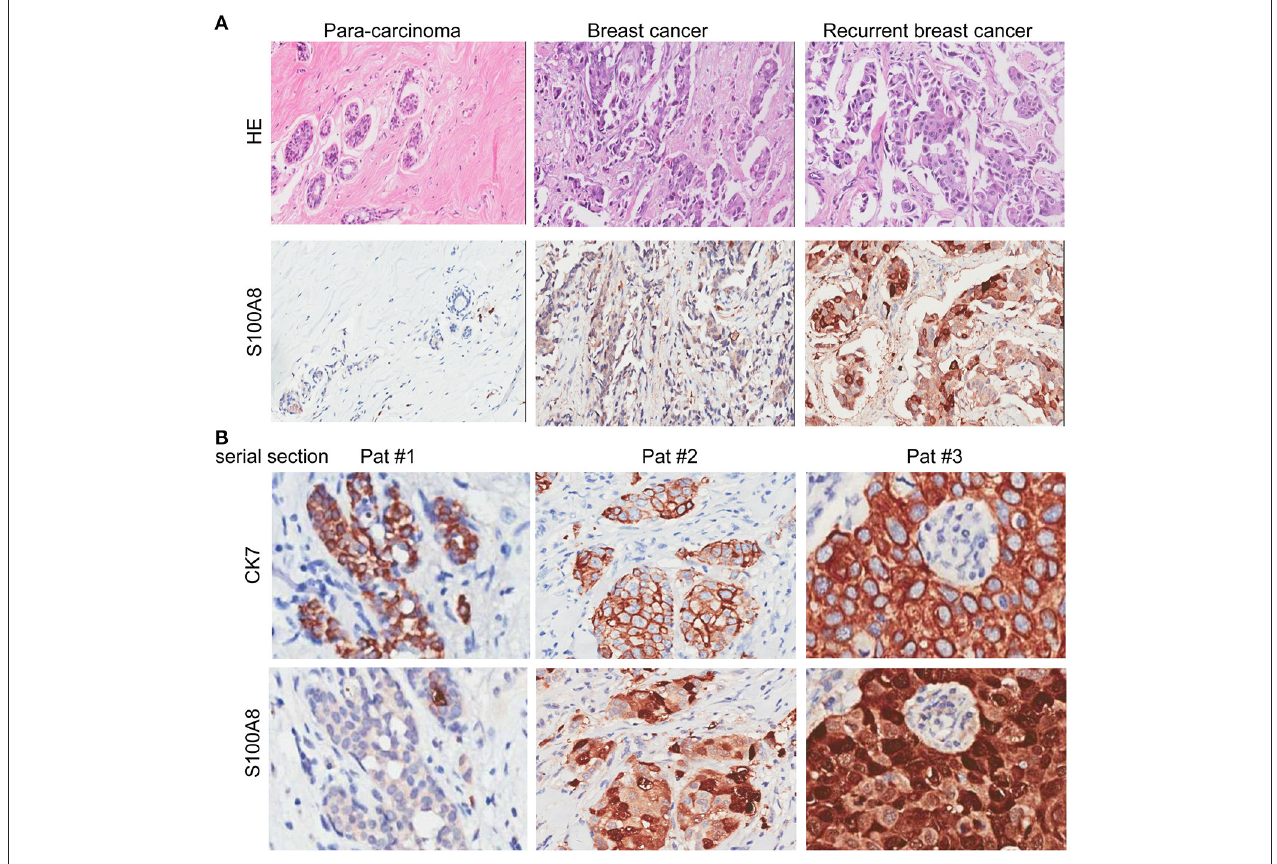
FIGURE 1 | HE and IHC staining of para-carcinoma, invasive breast cancer, and recurrent breast cancer tissue samples. (A) HE staining (top) and immunohistochemical staining (bottom) of the three types of tissue: para-carcinoma (left), invasive breast cancer (middle), and recurrent breast cancer (right). (B) Immunohistochemical analysis of CK7 (top) and S100A8 (bottom) expression with serial section in three patients.